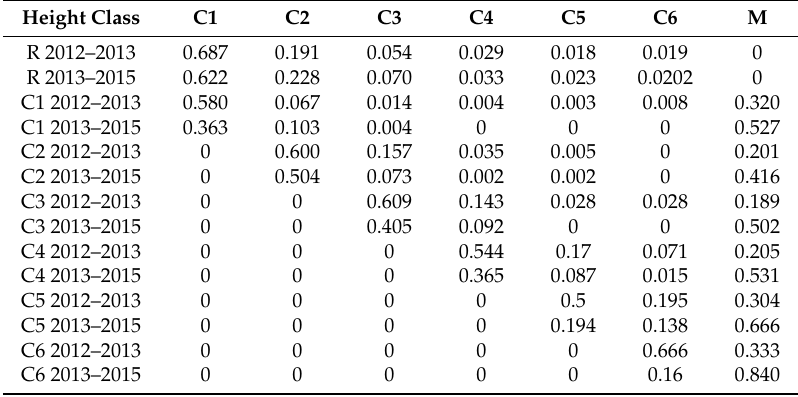
Table 2. Probabilistic transition of height (m) classes for Mora paraensis in Mazagão, south-eastern Amapá, Brazil, eastern Amazon, for the period 2012 to 2013 and 2013 to 2015. Where: R = Recruitment; M = Mortality; C1 (0.50–1.50 m); C2 (1.51–2.50 m); C3 (2.51–3.50 m); C4 (3.51–4.50 m); C5 (4.51–5.50 m); C6 (5.51–6.50 m).